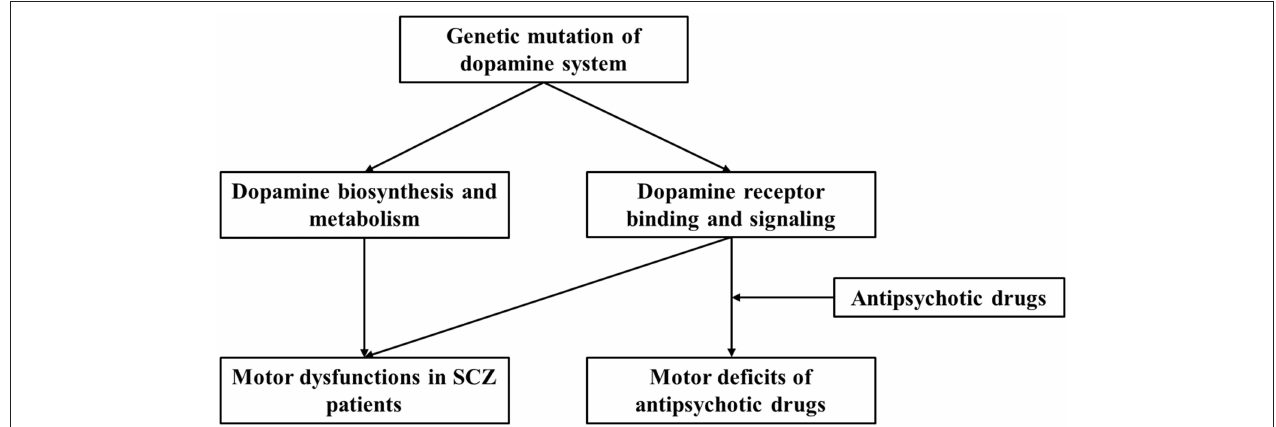
FIGURE 1 | Current working model for regulation of dopaminergic system and the effect of genetic polymorphism on motor dysfunction and antipsychotic drug-related motor deficits in SCZ patients.